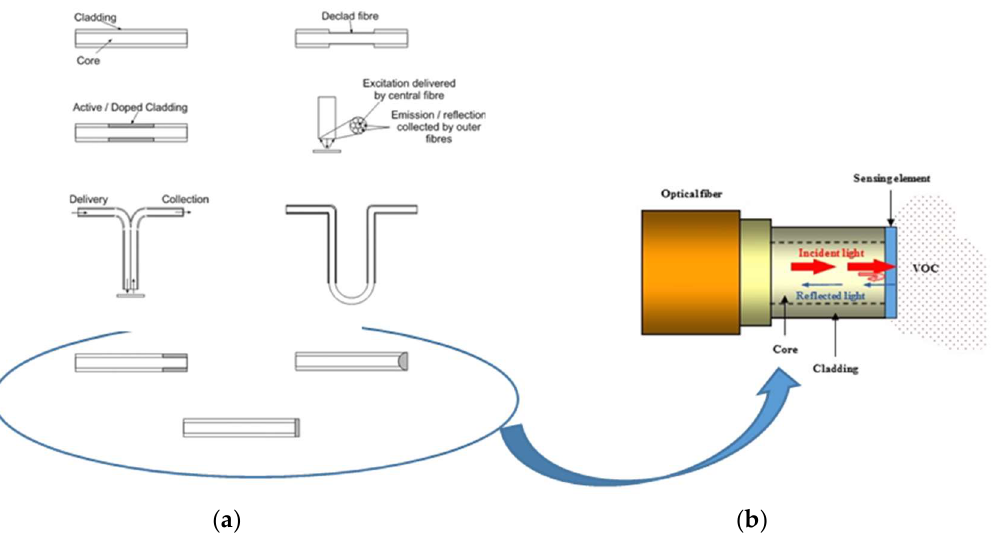
Figure 3. ( a ) Different geometries of optical fiber sensor elements; ( b ) diagram of an FOS with reflection geometry (elaborated from Estella et al. 2010).